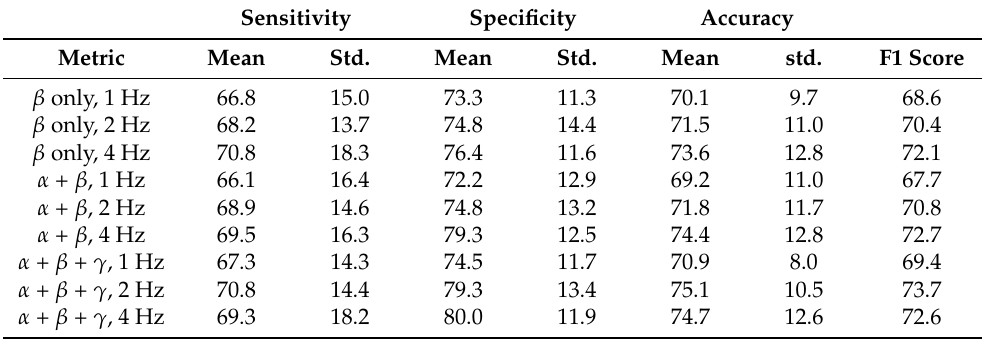
Table 3. Results for experiment II using BPNN. The numbers given are